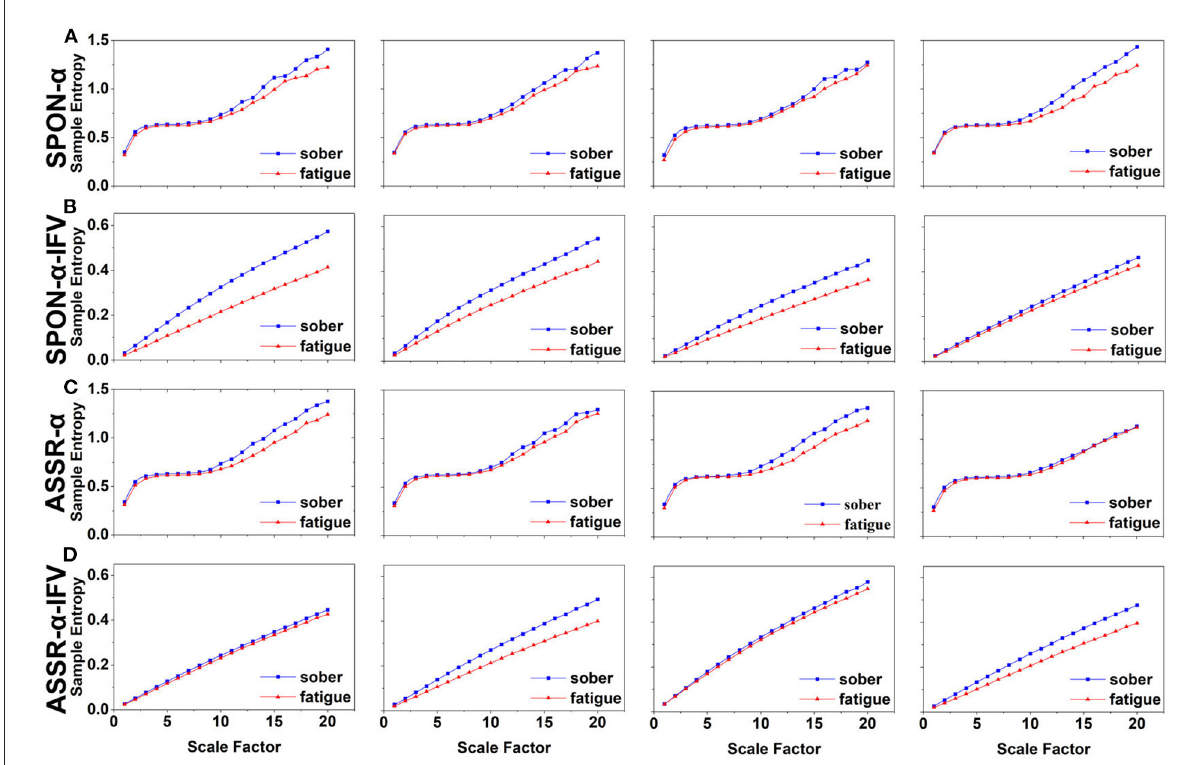
FIGURE5 MSE analysis of SPON- α (A) , ASSR- α (B) , SPON- α -IFV (C) , and ASSR- α -IFV (D) on occipital lobe (channel O1) from four exemplary subjects. The blue and red lines represent the Sober and MF states, respectively. See Section 2.5 for the definitions of terms.